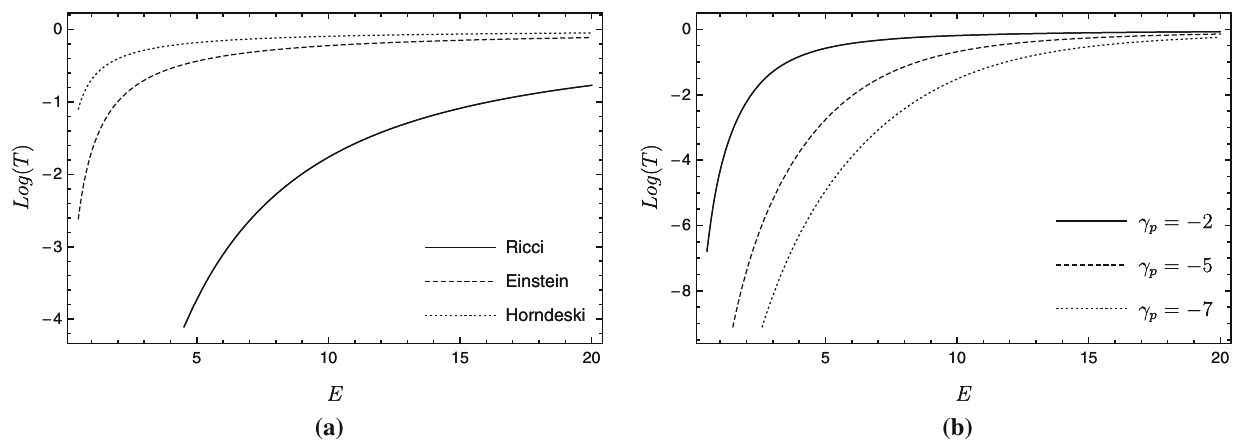
. a Ricci, Einstein and T